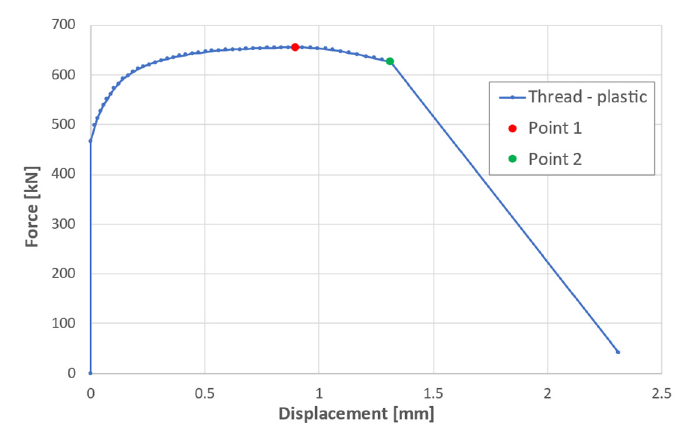
Figure 7. Parameters used to define damage to bolt–nut interaction.